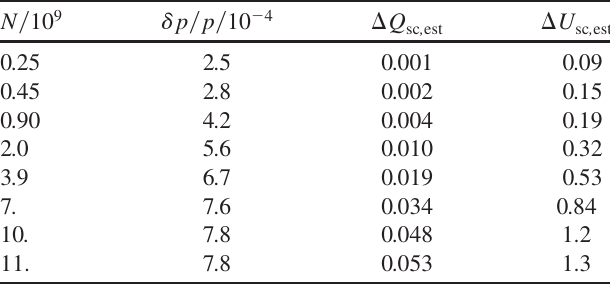
TABLE I. Measured particle number and momentum spread. In addition, the estimation of the space-charge tune-shift and the space-charge parameter are